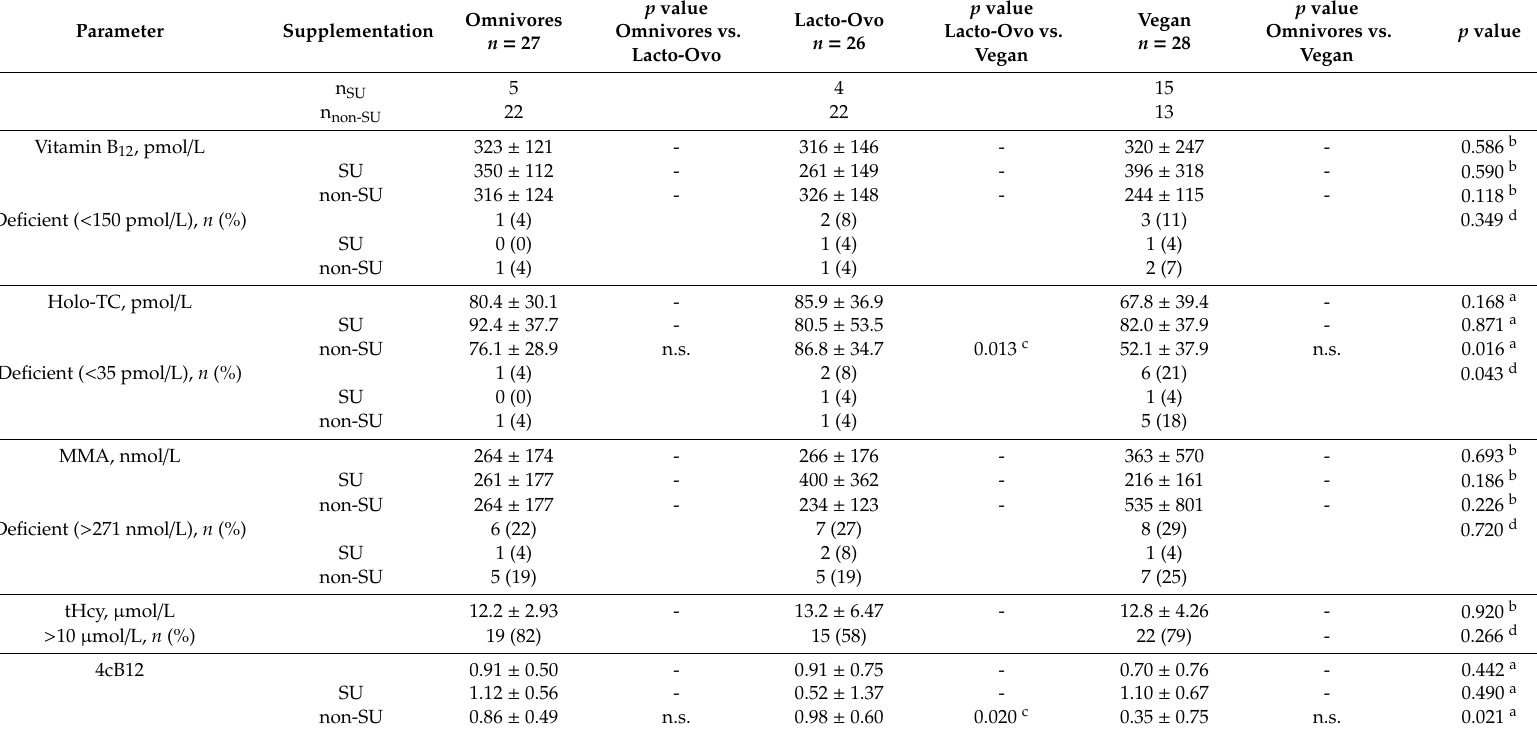
Table 2. Biomarkers of Vitamin B 12